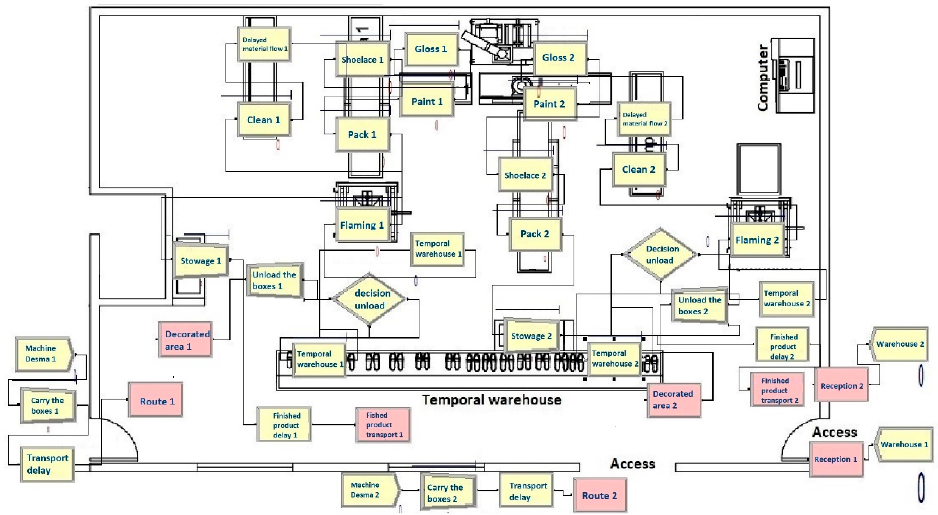
Figure 9. Arena ™ Model, current system, elaborated by the author.